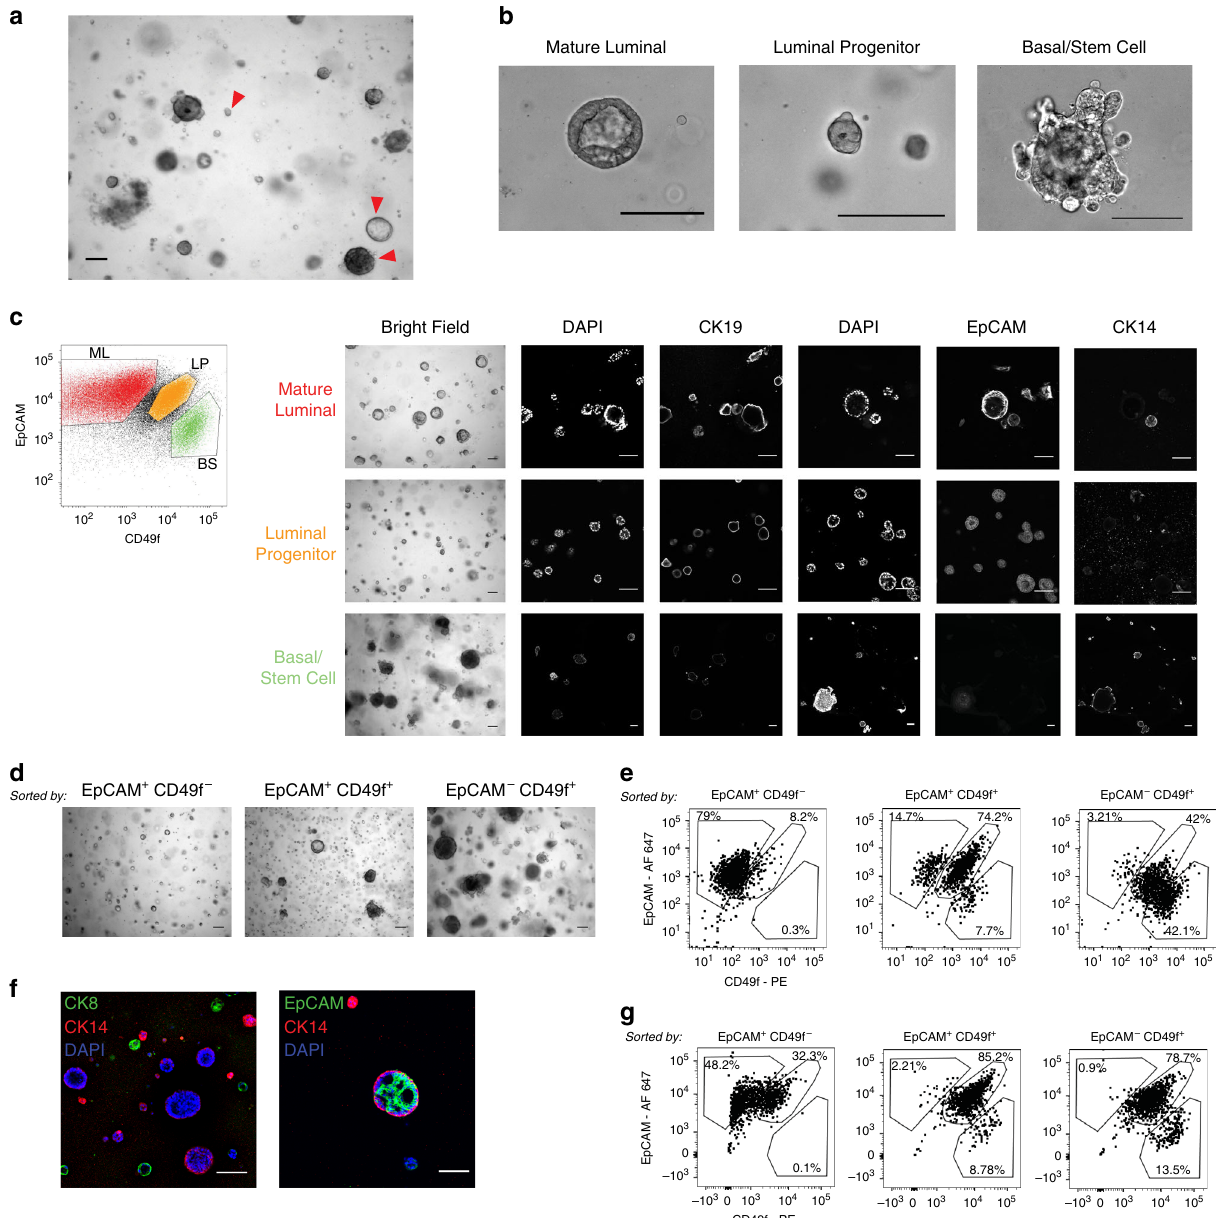
Fig. 2 Breast epithelial cell types form distinct structures in organoid culture. a Bright fi eld microscopy image of a representative organoid culture demonstrating multiple structure types, highlighted by red arrowheads. b Representative examples of organoid morphology for each of the indicated mammary cell lineages. c Cells from an organoid culture (representative of n = 9 cultures) were stained for EpCAM and CD49f, and sorted using FACS into mature luminal (ML, red), luminal progenitor (LP, orange), and basal/stem cell (BS, green) populations. Cells were recultured as organoids, and then assessed by bright fi eld microscopy ( n = 9), or confocal microscopy after staining for the indicated markers (column 1, columns 2 – 3, and columns 4 – 6 are from separate images, n = 3). Scale bars = 100 µ m. d , e Cells of the indicated types were recultured after sorting for >6 weeks, then imaged by bright fi eld microscopy in d , (representative of n = 9, scale bar = 100 µ m), or analyzed for EpCAM and CD49f expression by fl ow cytometry in e . Cultures with luminal progenitor cells that differentiated to generate other mammary cell types were ORG7, ORG43, ORG46, ORG48, ORG49, and ORG51. ORG41, ORG42, and ORG50 had luminal progenitor cells that did not differentiate to generate other mammary cell types. f Luminal progenitor cells (EpCAM + CD49f + ) sorted from two different organoid cultures were recultured as organoids, stained for CK8 (green) or EpCAM (green), CK14 (red), and with DAPI (blue), and imaged by confocal microscopy (representative of n = 6, scale bar = 100 µ m). g Cells were double-sorted for EpCAM and CD49f, then re-grown and assayed as in e